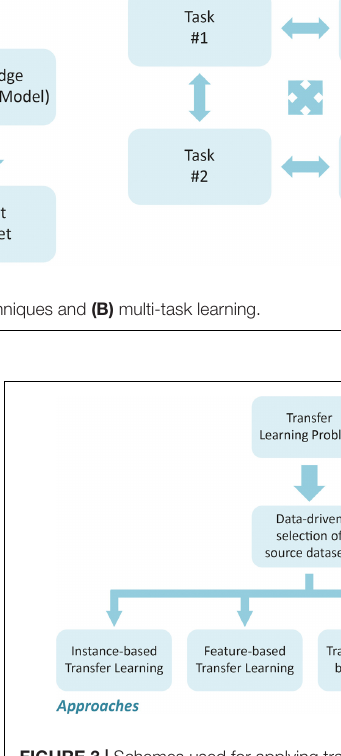
FIGURE 3 | Schemes used for applying transfer learning approaches.